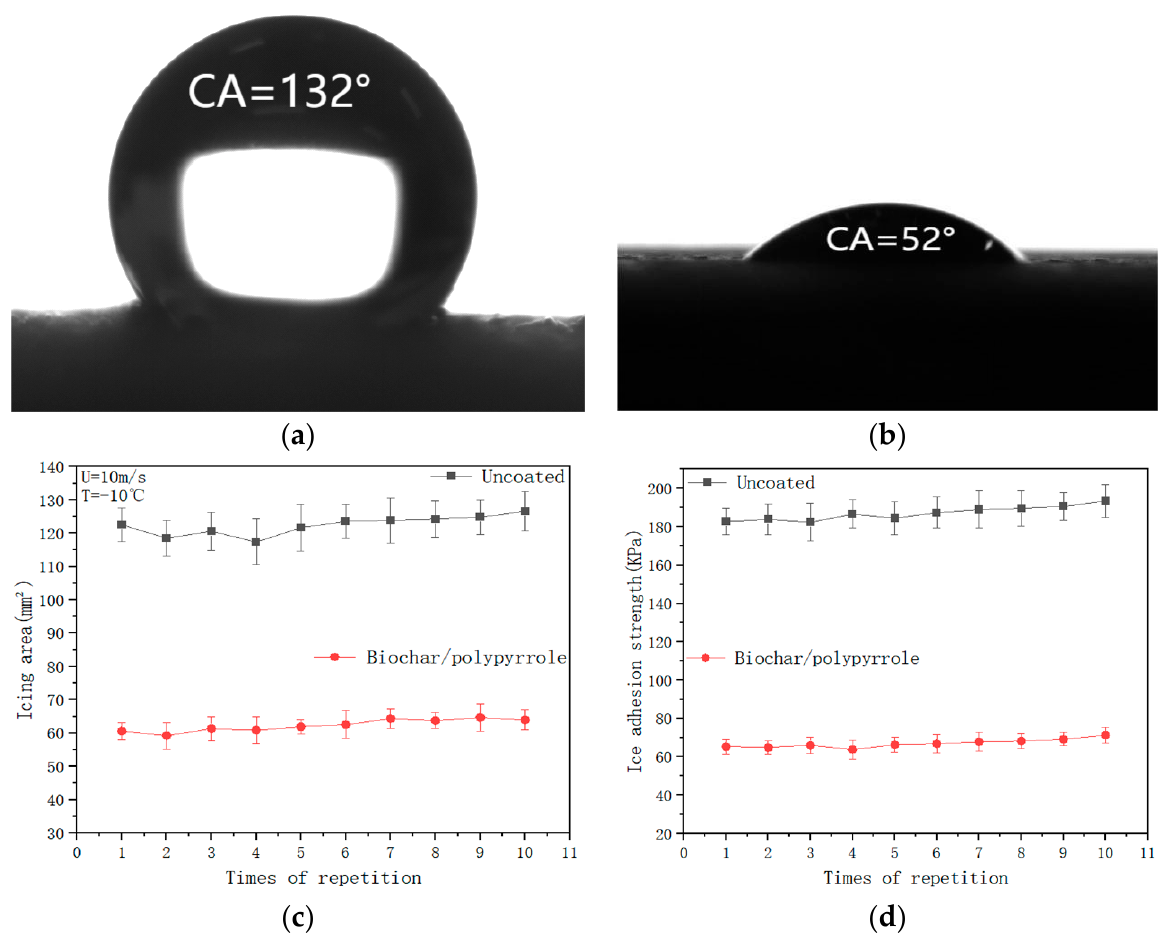
Figure 6. ( a ) Contact angle after wear of the biochar/polypyrrole coating. ( b ) Contact angle after wear of the uncoated coating. ( c ) Repeat ten wind tunnel test area changes. ( d ) Comparison of ten repeated ice-bond strength tests. Table 5. The icing bond strength change of biochar/polypyrrole